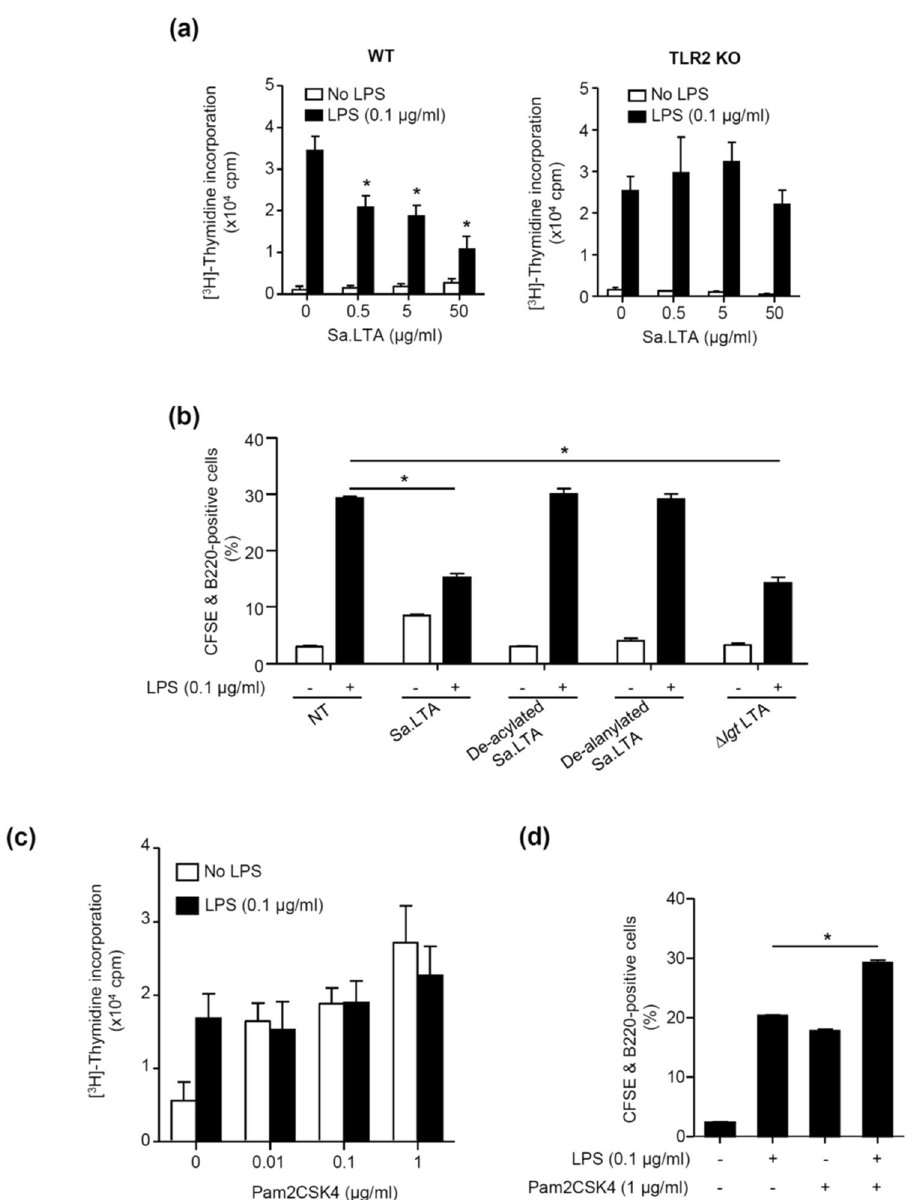
Figure 2. Sa.LTA-mediated inhibitory effect of B cell proliferation is involved in TLR2. ( a ) Splenocytes (1 × 10 6 cells/ml) were isolated from wild-type or TLR2-deficient C57BL/6 mice and stimulated with the indicated concentrations of Sa.LTA and/or LPS for 72 h. Then, cell proliferation was determined by [ 3 H]-thymidine incorporation. Data are expressed as the average cpm ± standard deviation of three separate experiments. * P < 0.05 compared with LPS treatment group without Sa.LTA. ( b ) CFSE-labeled splenocytes (1 × 10 6 cells/ ml) were incubated with de-acylated LTA, de-alanylated LTA or LTA from the S. aureus Δ lgt strain (50 μ g/ml each) in the absence or presence of LPS (0.1 μ g/ml) for 72 h. Then, the cells were stained with PerCP-conjugated rat anti-mouse CD45R/B220 antibody and B cell proliferation was determined by flow cytometry. NT denotes non-treatment. ( c ) Splenocytes (1 × 10 6 cells/ml) were stimulated with Pam2CSK4 and/or LPS at the indicated concentrations for 72 h and cell proliferation was determined by [ 3 H]-thymidine incorporation. Data are expressed as the average cpm ± standard deviation of three separate experiments. * P < 0.05 compared with control culture without LPS stimulation. ( d ) CFSE-labeled splenocytes were stimulated with Pam2CSK4 (1 μ g/ ml) and/or LPS (0.1 μ g/ml) for 72 h. Then, the cells were stained with PerCP-conjugated rat anti-mouse CD45R/ B220 antibody and B cell proliferation was determined by flow